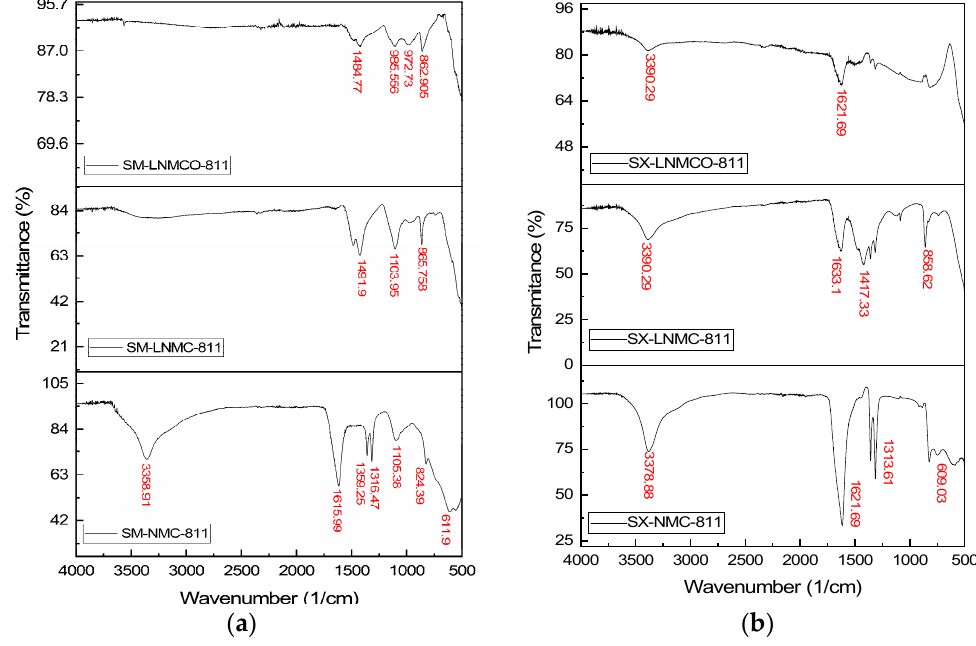
Figure 2. FTIR spectra of the synthesized NMC 811 cathode precursors after co-precipitation, lithiation, and sintering stages. ( a ) MHP as the source of Ni, ( b ) nickel sulfate as the source of Ni.